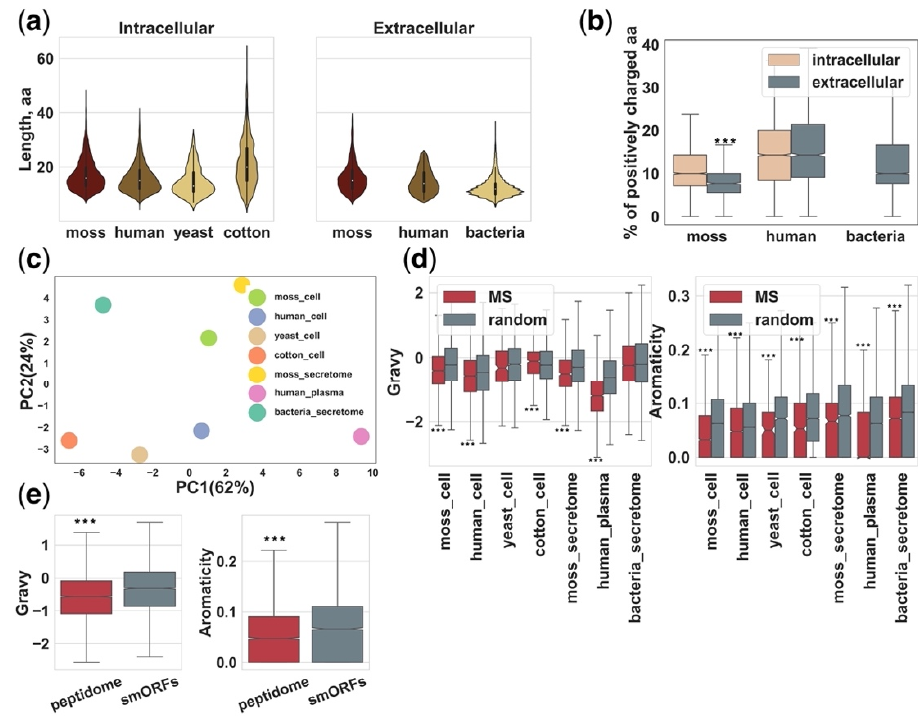
Figure 3. The properties of peptidomes identified by mass-spectrometry analysis. ( a ) The lengths distribution of intracellular peptides from moss [15], cotton [62], human [64], yeast [65] and extra- cellular peptides from human plasma [12], moss [15,16] and bacteria [63] datasets. ( b ) The percent of positively charged amino acids in peptides from different datasets. All calculations were per- formed by iFeature tool [119]. ( c ) Principal component analysis of the physicochemical properties of composition, transition and distribution (CTD) of the peptidomes from different organisms. The 2D plot demonstrates separation of peptidome’s amino acid composition in different datasets and clusterization of intracellular and extracellular datasets. All calculations were performed by iFeature tool [119]. ( d ) A comparison of the GRAVY indices and the proportion of aromatic acids between MS-identified peptides and sets of random peptides from the same proteins. The sets of random peptides were separately generated from the corresponding precursors for each dataset. All calculations were performed by Biopython [120]. ( e ) Comparison of the GRAVY indices and the proportion of aromatic acids in mass-spectrometry identified peptides from intracellular proteins [64] and small open reading frames [37] from human. *** p < 10–5 Mann–Whitney U-test. The